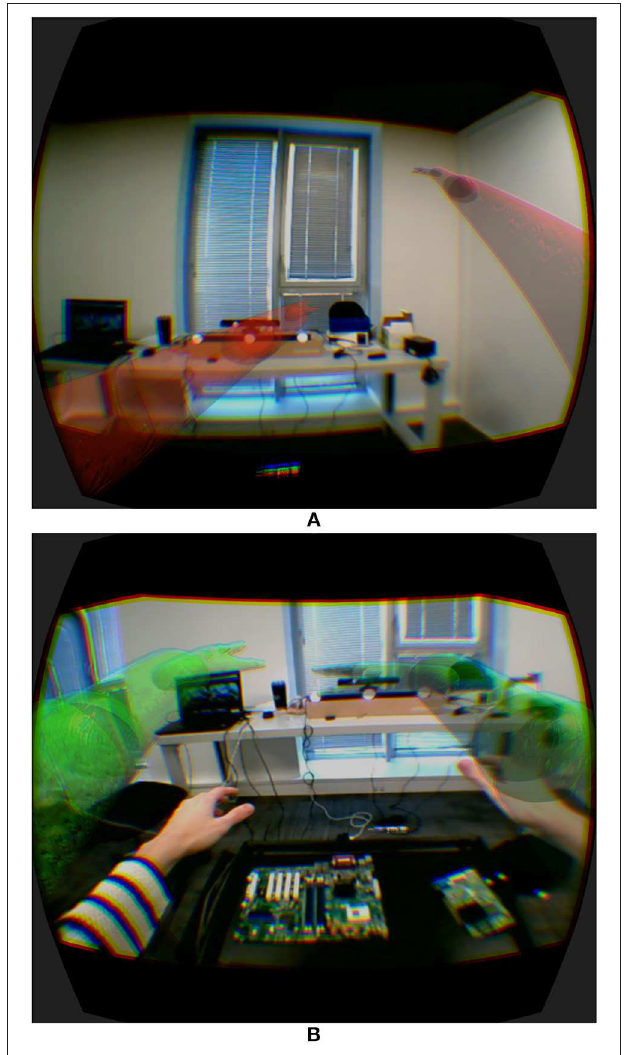
FIGURE 7 | Stretchable guiding arms, controlled from the remote expert’s location, from the agent’s viewpoint. (A) In the top image, the arms are extended, and are shown in red because the guide is ahead of the agent. (B) In the bottom image, the agent has reached the guide’s location and the guiding arms return to their initial length and are shown in green.